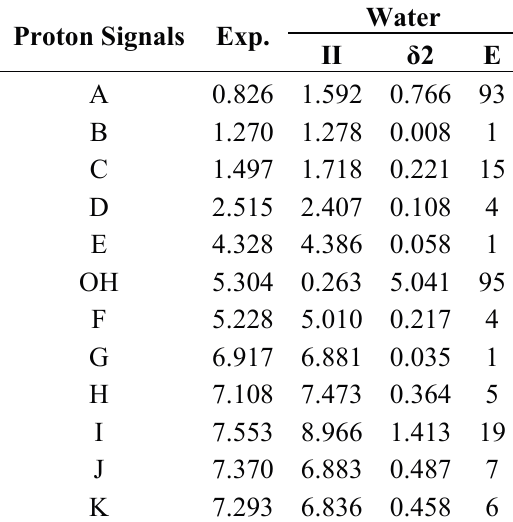
Table 1. Calculated and experimental data recorded at 293 K for losartan anion ( 1 ) Rotamer II (isomer syn ); the following parameters were determined for their proton groups: experimental (Exp.) and calculated values of the chemical shifts (II), absolute errors ( δ 2) and values of the relative percentage errors (E); calculated NMR shielding for proton H ref = 31.740 ppm for TMS (tetramethylsilane) (B3LYP/6-31G(d,p)/gauge-including atomic orbital (GIAO)/CPCM; R 2 = 0.73, mean absolute deviation (MAD) = 0.58. Water Proton Signals Exp. II